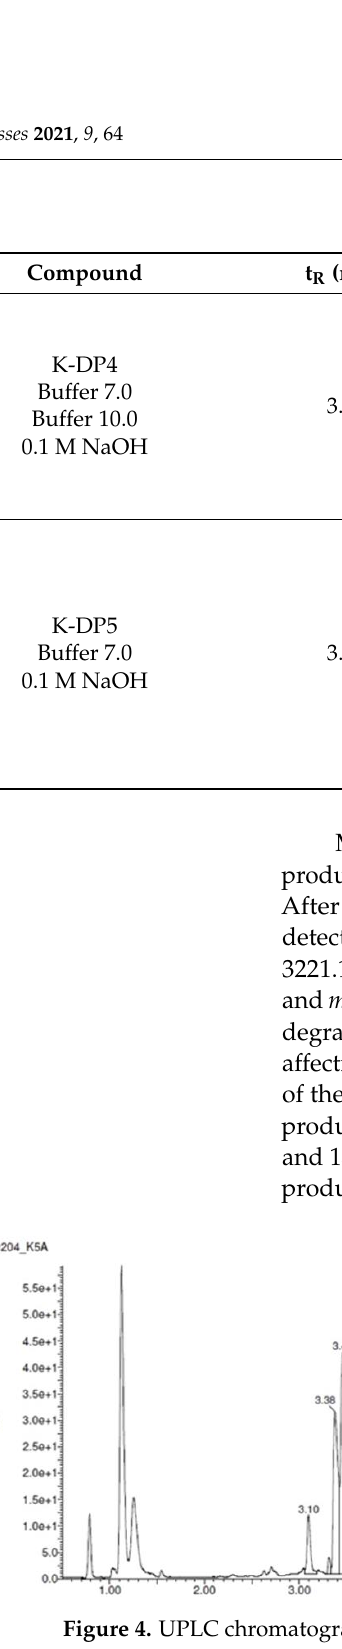
It is worth mentioning that the products K-DP3 and K-DP4 have not been reported